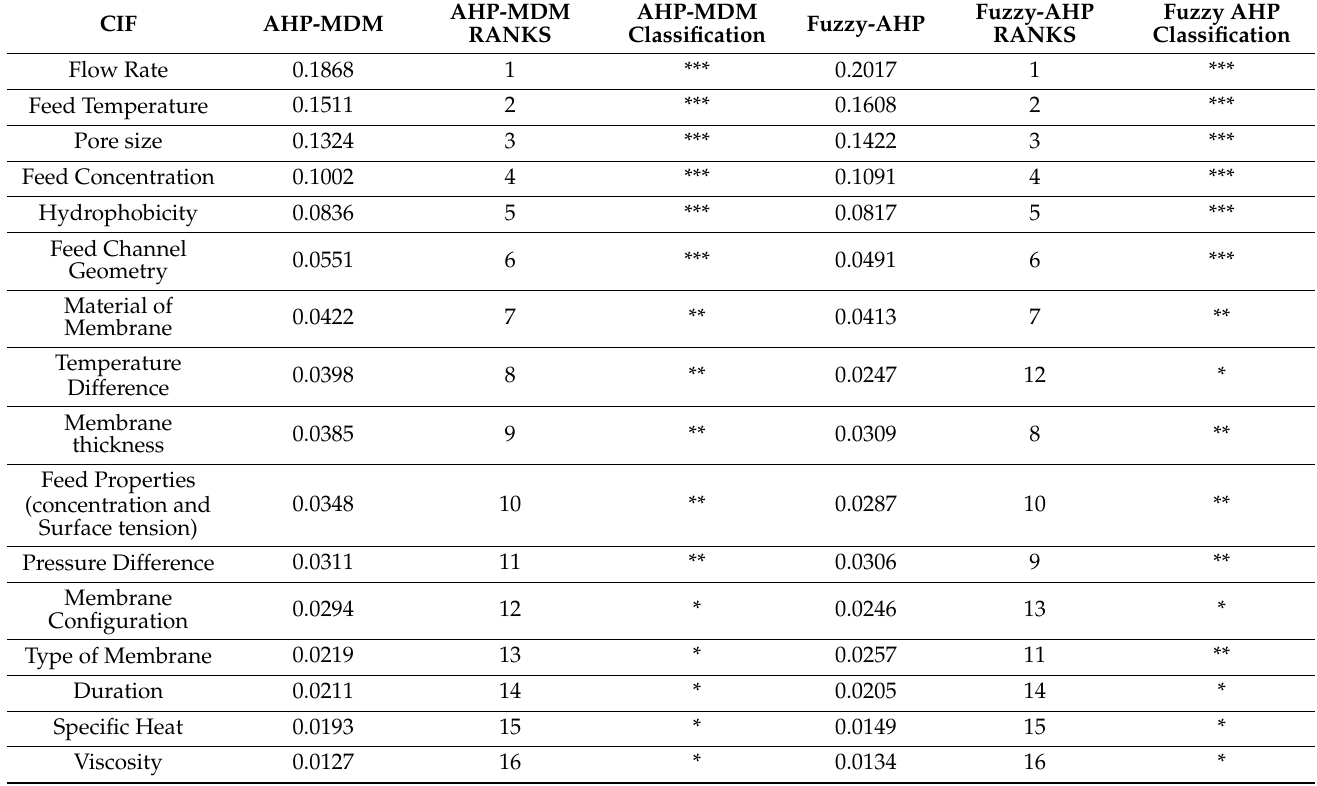
Table 9. Weightages and ranks of CIFs using AHP-MDM and